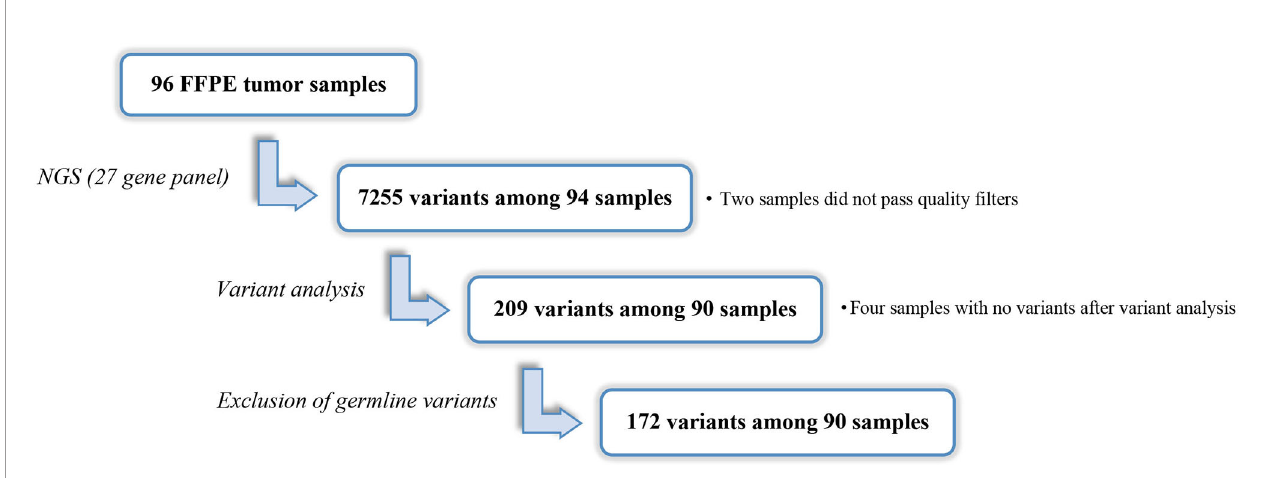
FIGURE 1 | Identi fi cation of somatic variants in tumor